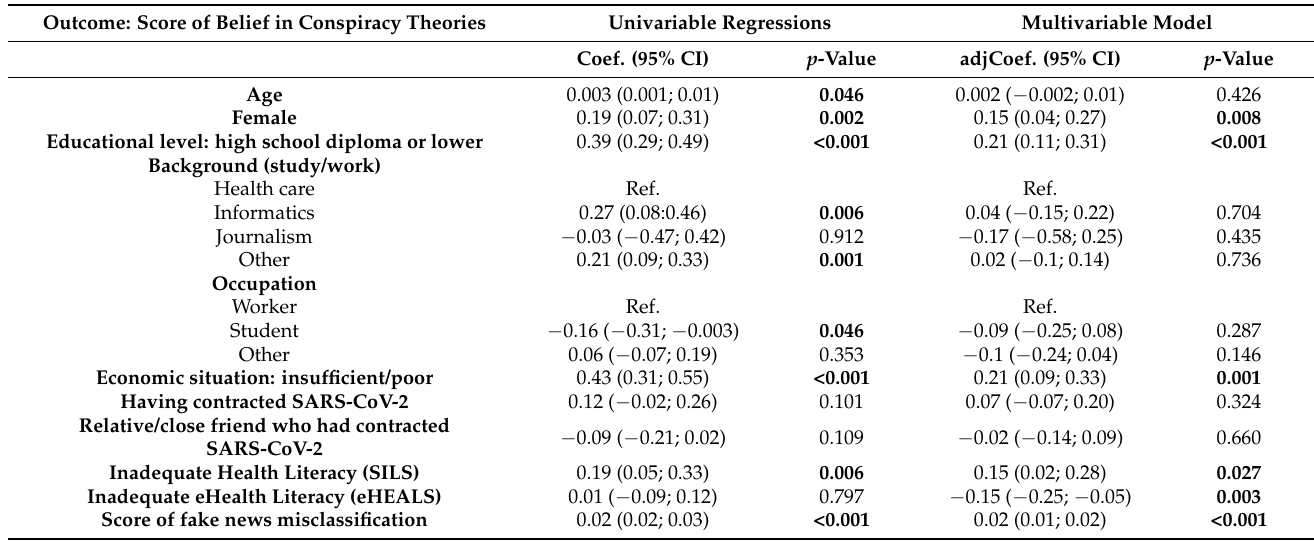
Table 5. Univariable and multivariable logistic regressions with the score of belief in conspiracy theories as